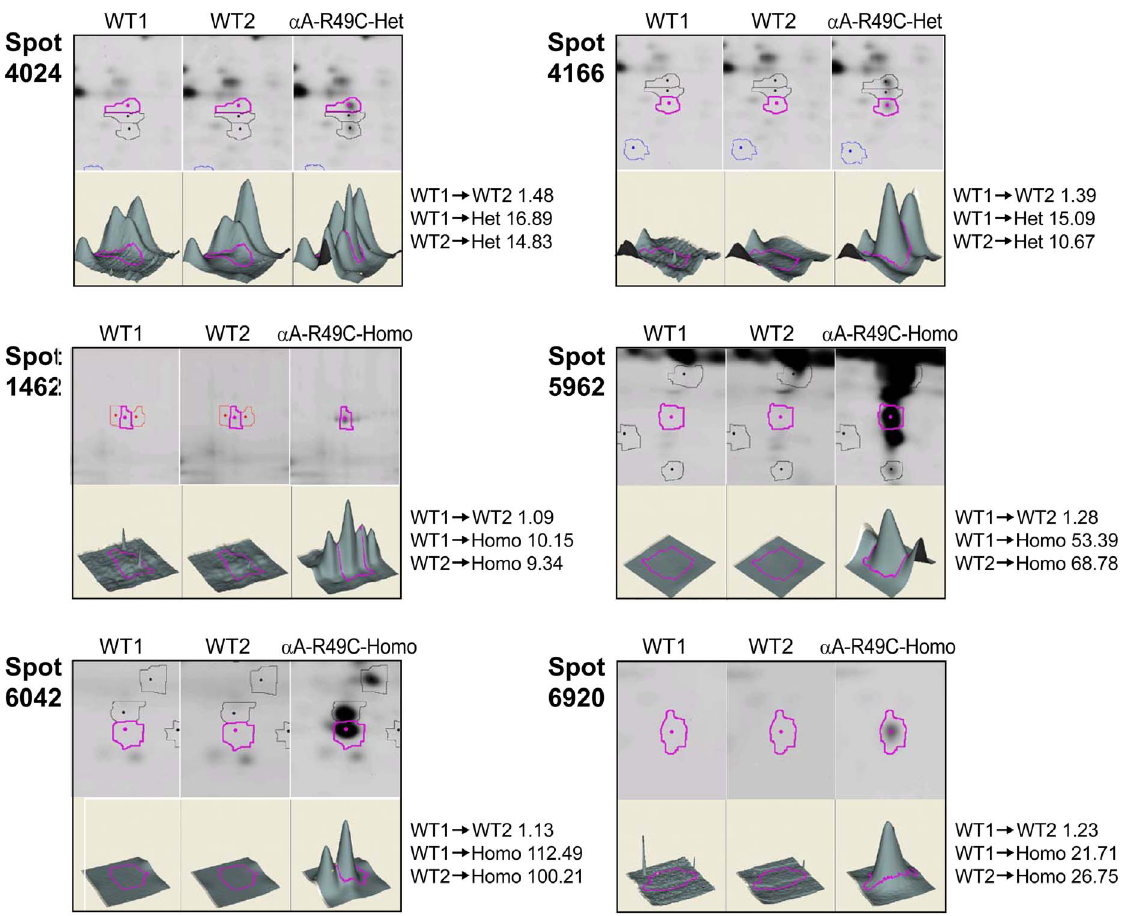
Figure 2. Quantitative analysis of abundance changes in proteins from postnatal 2-day-old WT and a A-R49C knock-in lenses by mass spectrometry. The 3D data sets for representative proteins in two WT (WT1 and WT2) and one a A-R49C heterozygous or a A-R49C homozygous mutant sample are shown. WT1 and WT2 proteins were labeled with Cy2 and Cy3 dyes, respectively and a A-R49C mutant proteins with Cy5. Fold changes between each sample are indicated on the right. See Table 1 for the identity of proteins present in each protein spot.